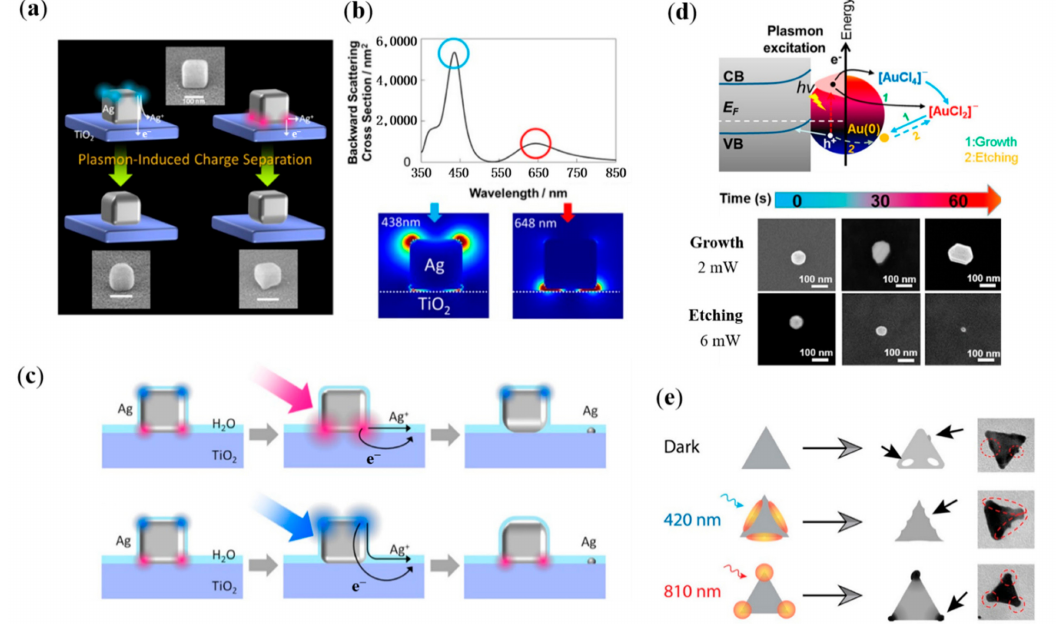
Figure 3. Plasmon-assisted etching of plasmonic nanostructure. ( a – c ) Plasmon-assisted site-selective etching of Ag nanocubes [71]. ( a ) Schematic diagram. ( b ) Scattering spectra and EM field distribution of the Ag nanocubes on the TiO 2 . ( c ) Plasmon-assisted electron transition at the interface and site- selective etching of nanocubes. ( d ) Schematic illustration and SEM images of hot carrier-assisted growth/etching of Au NPs [72]. ( e ) Plasmon-assisted spatially controlled replacement reactions on Ag nanoprism